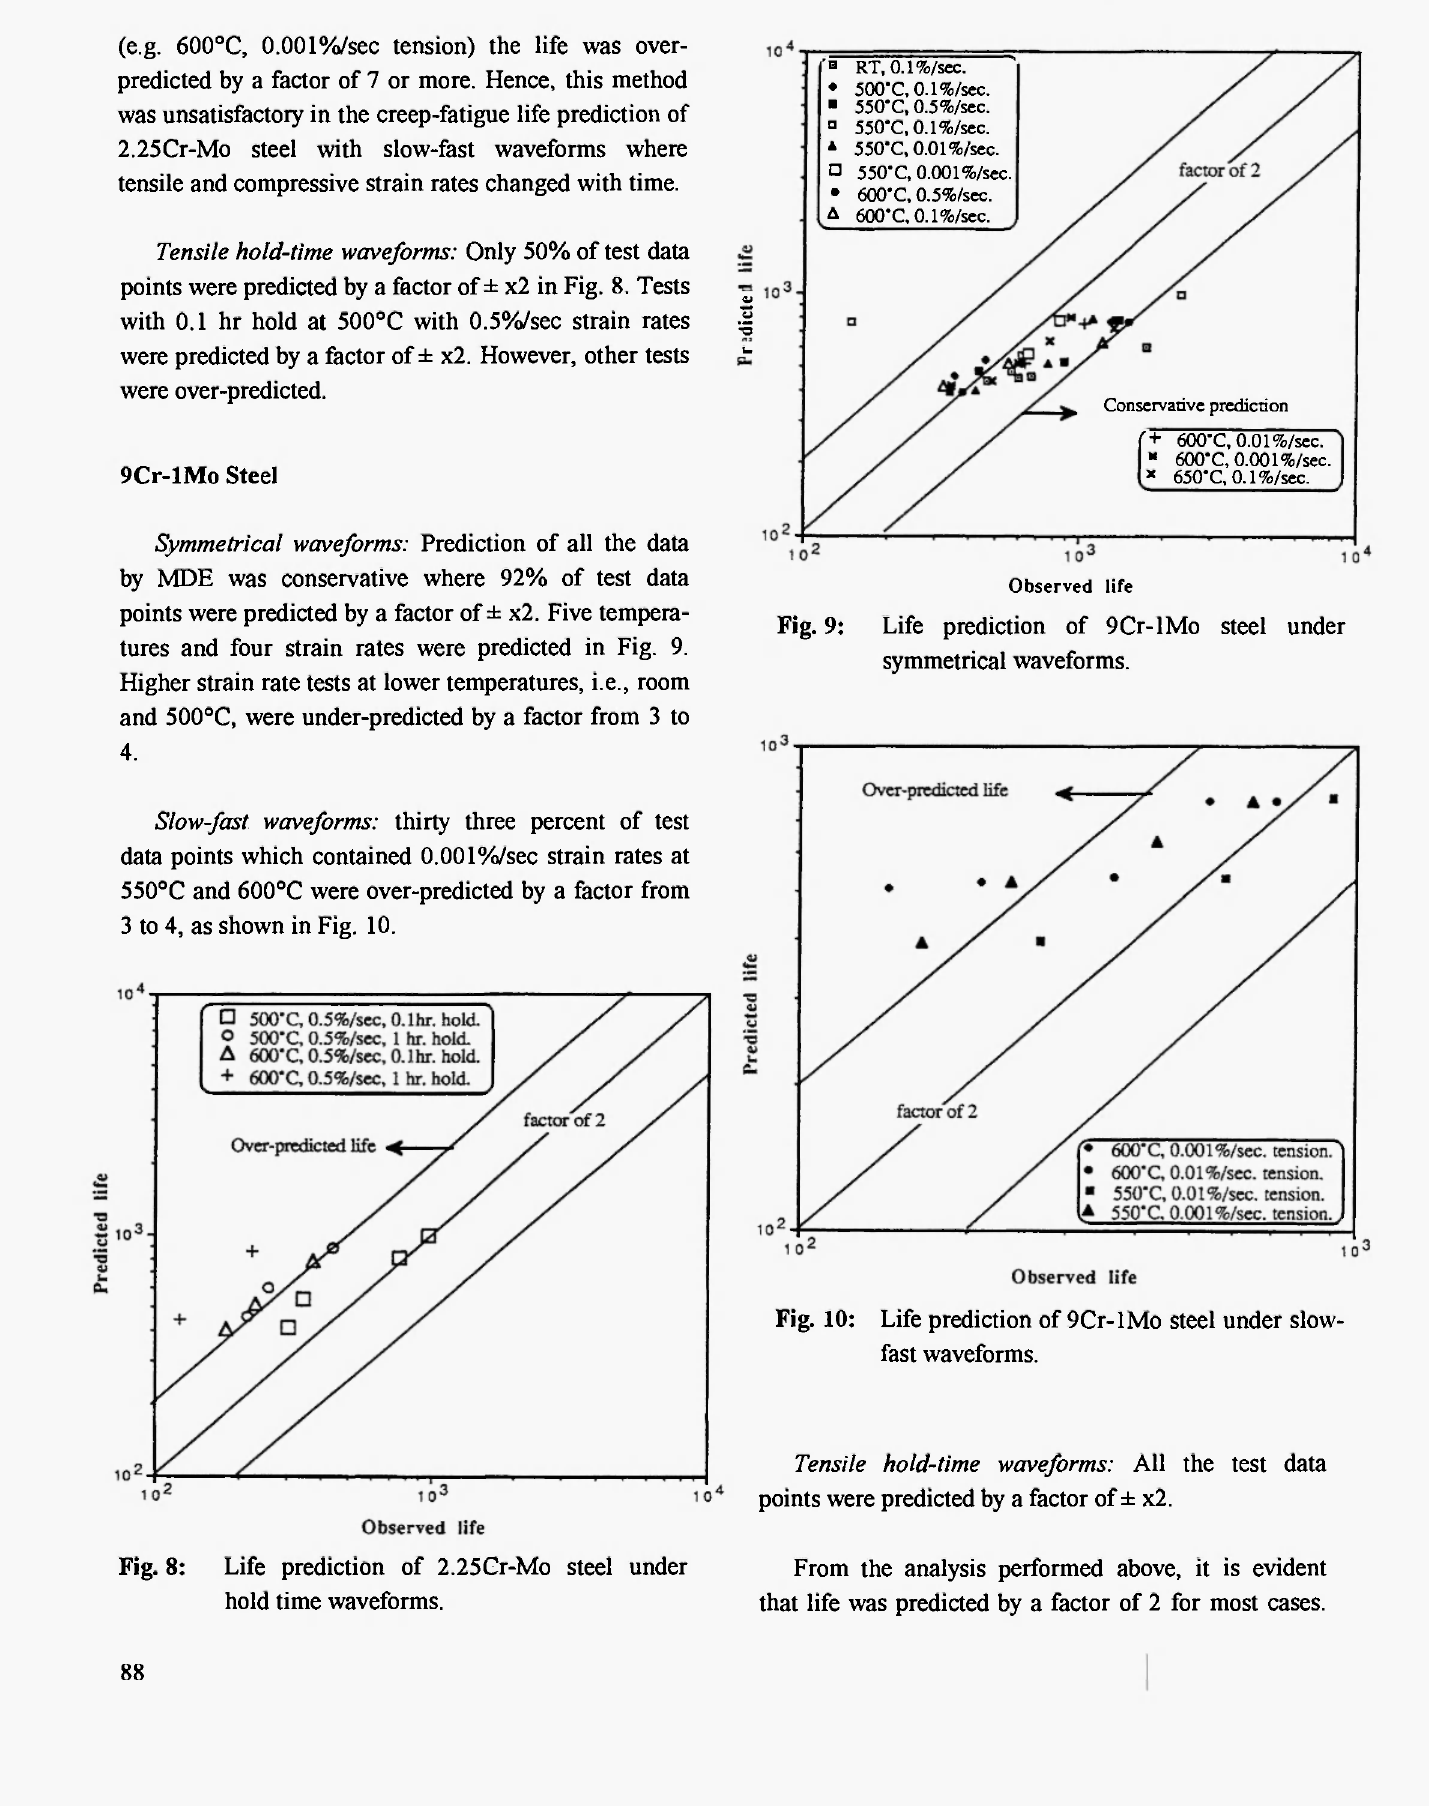
Fig. 8: Life prediction of 2.25Gr-Mo steel under hold time waveforms.